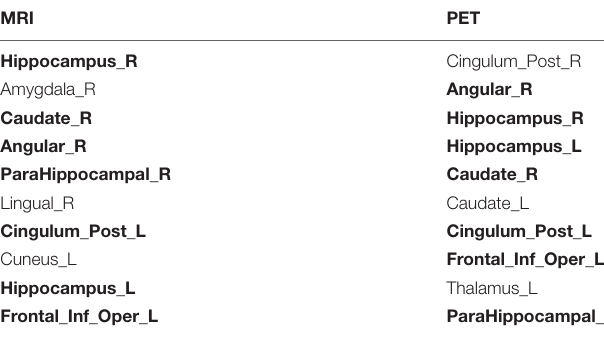
TABLE 4 | The top ten selected ROIs by the proposed model. MRI PET